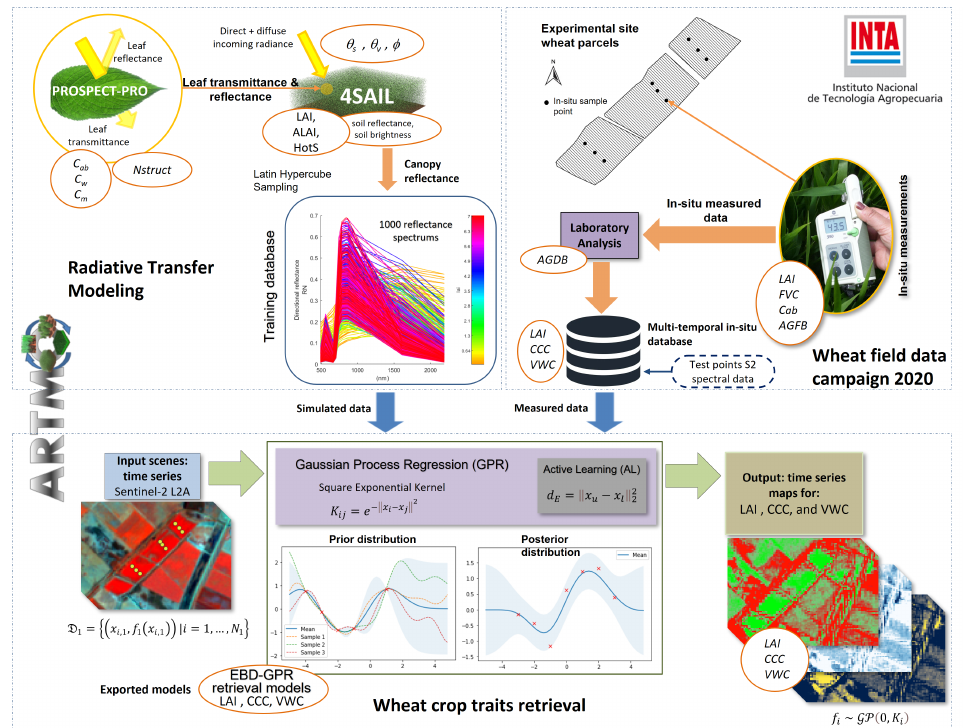
Figure 4. Illustration of the hybrid retrieval workflow using the coupled PROSAIL-PRO models to establish a training database for the GPR, partly adapted from [82]. The output maps show our vegetation traits modeling over the BVCR area in